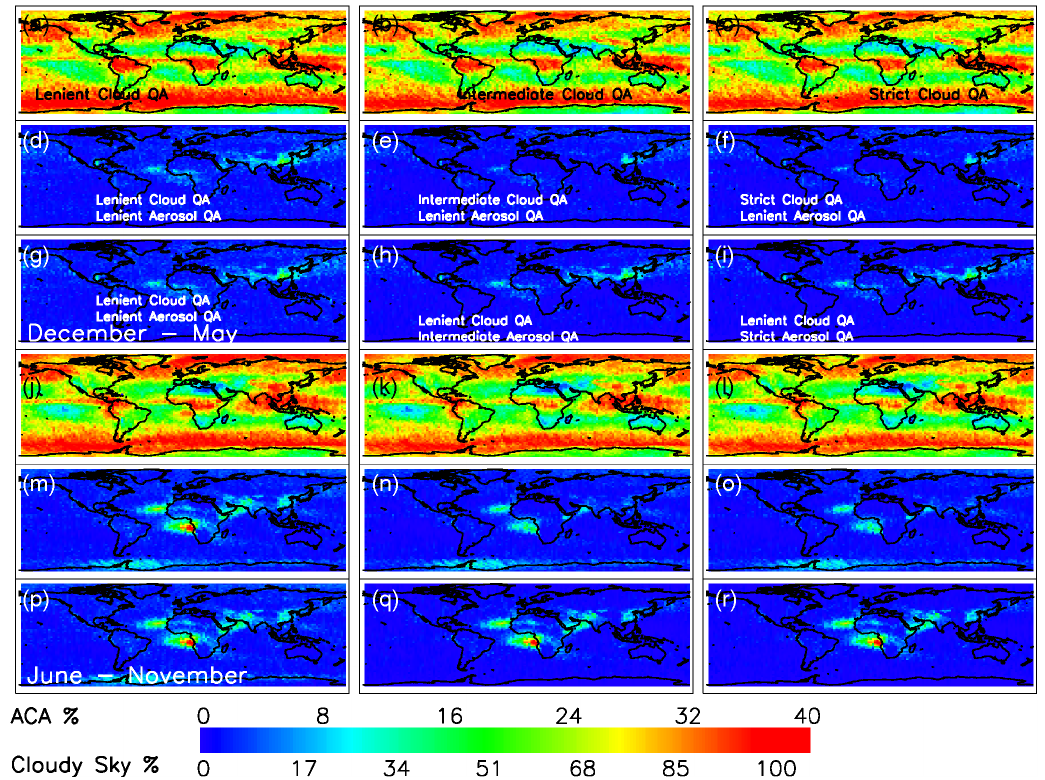
Figure 9. (a) Two-and-a-half-year (June 2006 to November 2008) daytime CALIOP cloudy-sky frequency during the December through May period, using the collocated OMI-MODIS-CALIOP data set with the application of the most lenient cloud QA. Panels (b, c) depict the same information as Fig. 9A but now using intermediate and strict cloud QA settings, respectively. (d) Depicts the all-sky frequency using the same data set as Fig. 9A, now using lenient cloud and aerosol QAs. Panels (e, f) Depict the same information as (d) but varying the cloud QA to intermediate and strict. (g–i) Similar to (d–f) but holding the lenient cloud QA while varying the aerosol QA from lenient to intermediate and strict, respectively. Panels (j–r) depict the same information as (a–i) but for the June to November period